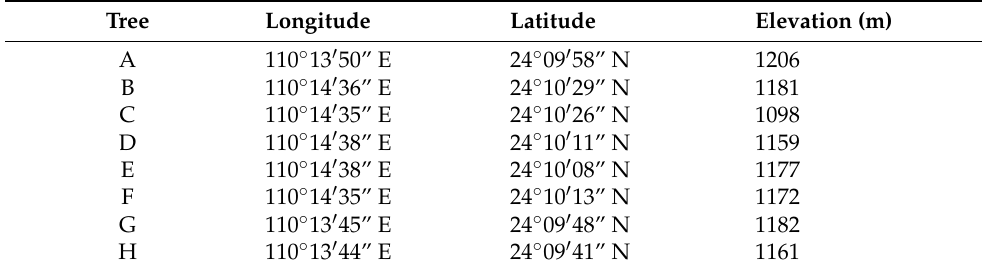
Table 1. Collection locations of eight trees of Manglietia crassipes.